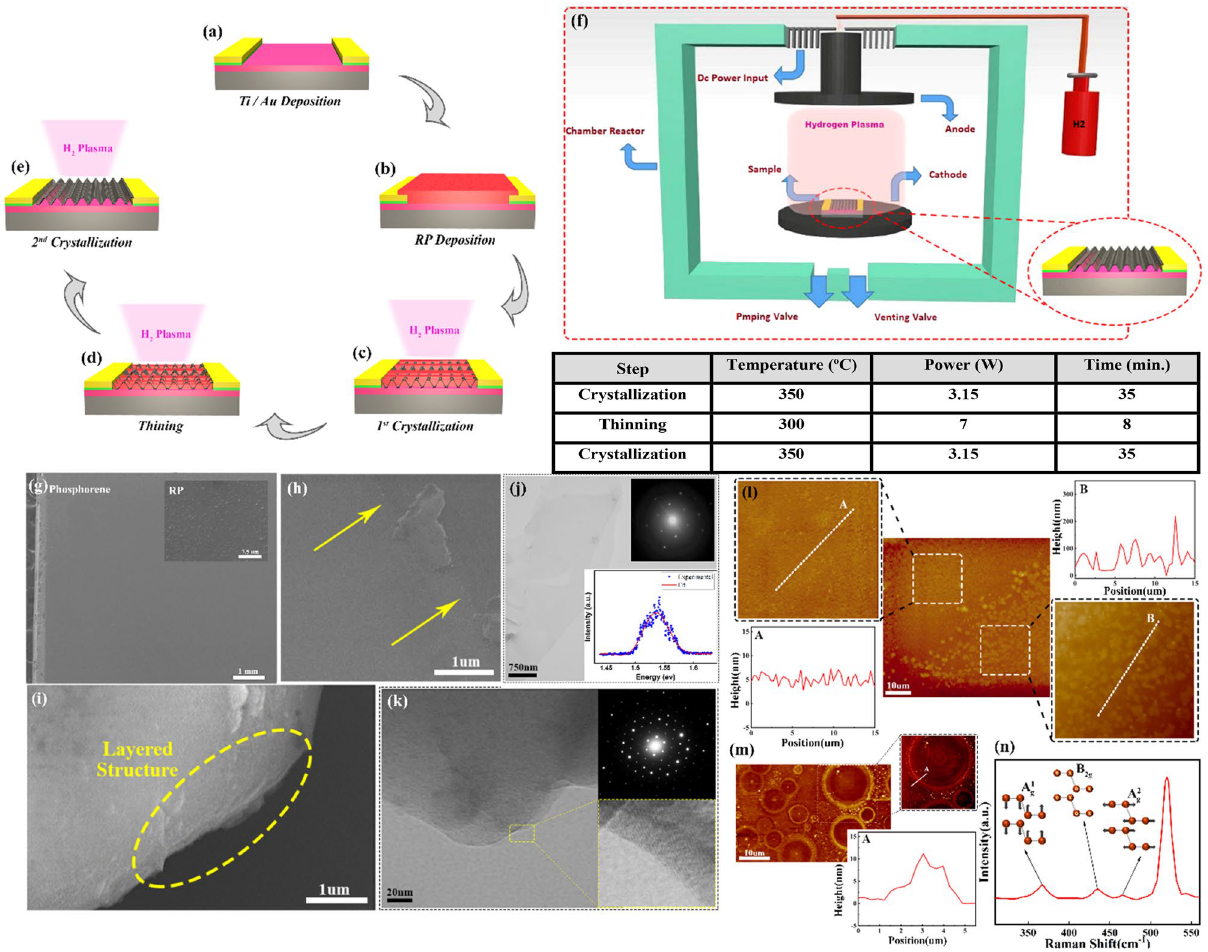
Figure 1. The synthesis process and material characterization: ( a-e ) Evolution of few-layer phosphorene sheets demonstrating the crystallization trend of the formation of a thoroughly crystalline layers: ( a ) Pre-lithography, ( b ) Initial amorphous layer, ( c ) first crystallization, ( d ) Thinning and ( e ) the second crystallization steps. ( f ) The schematic image of dc_PECVD as well as test parameters of the sequential hydrogen plasma treatment. ( g ) A low-magnification SEM image of phosphorene sheet grown on a silicon substrate, illustrating an ultra-large area with no sign of stacked or bulk inclusion. The inset shows the deposited RP layer before the plasma treatment. ( h ) An SEM image of the edge of a sample corroborating the conformal and ultra-thin phosphorene layer on a silicon substrate. ( i ) An SEM image of the edge of a thick phosphorene layers indicating layered structure of the synthesized sheets. ( j ) An ultra-large mono-layer phosphorene. The top inset shows a clear diffraction pattern confirming the formation a crystal layer. The bottom inset confirms the existence of monolayer phosphorene through the photoluminescence analysis. ( k ) Bright field and high-resolution TEM image beside the corresponding diffraction pattern of a few-layer phosphorene sheet. ( l ) A comparison between AFM micrographs of the surface roughness of the sample (A) after and (B) before the sequential plasma treatment. ( m ) AFM micrograph from the surface degradation of a phosphorene layer appeared after one-day exposure to the ambient situation. ( n ) Raman spectrum of a highly crystalline few-layer phosphorene Accordingly, a sequential hydrogen (H 2 ) plasma process has been developed including three sequences: initial crystallization, thinning and final crystallization. In all sequences, the RP-coated substrate is placed on the lower plate (cathode) of two parallel stainless-steel electrodes and the defined parameters including temperature of the reactor, plasma power, type, and flow of the carrier gas, are then set for each step. At first, hydrogen carrier gas with a flow rate of 10 sccm is introduced to the chamber to smoothly elevate the temperature throughout the quartz tube and then along the first sequence, so called 1st crystallization, a 35-min plasma treatment is applied with a dc power of 4 Watt at a moderate temperature of 350 °C. In initial moments when the possibility of evaporation compared to crystallization is more likely to happen, a preliminary thinning occurs but most of the imparted energy has been devoted to crystallizing the layer and as the time lapses, a denser and more stable layer will be formed. We assume that this reconfiguration in atomic arrangement, which is called crystallization, is due to impingement of the present reactive species in plasma on the surface of the sample. In this sequence, the interactions between the phosphorus atoms and the hydrogen ions and radicals result in the diffusion of